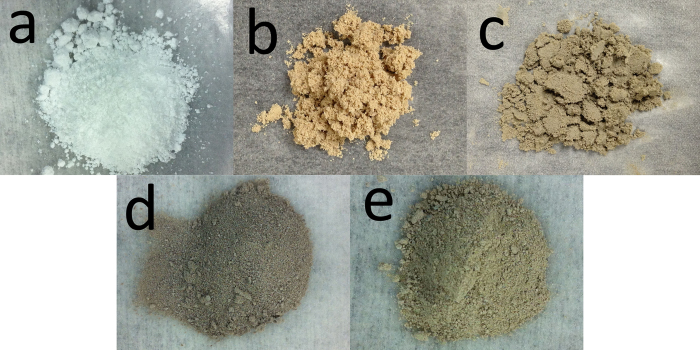
Photographs of pristine TiO2(a) and doped TiO2 samples, (b) TiO2-1, (c) TiO2-2, (d) TiO2-3 and (e) TiO2-4.